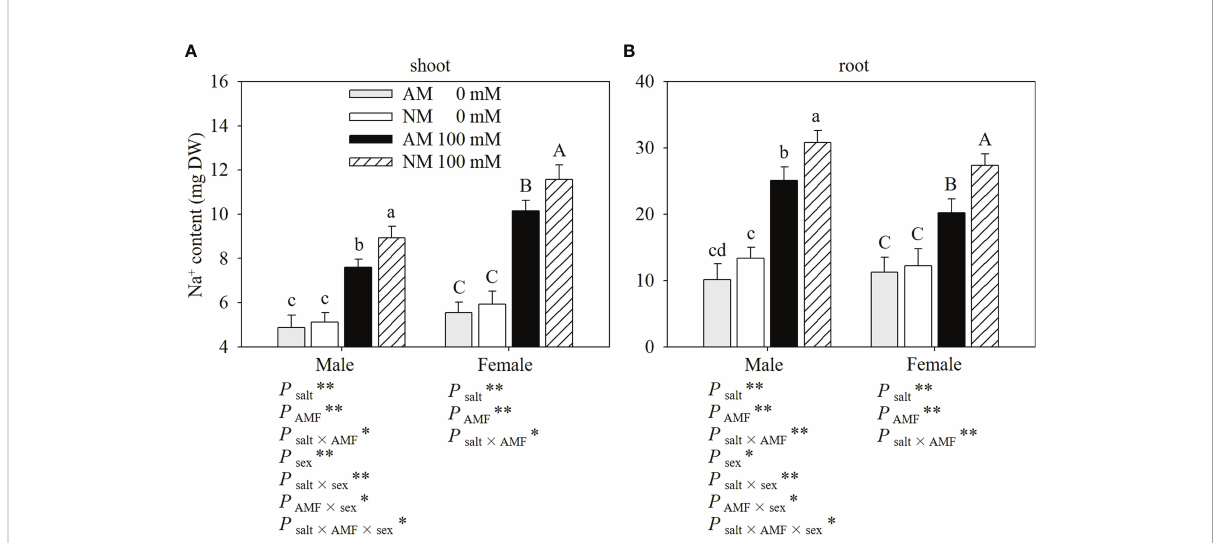
FIGURE 3 Effects of AMF inoculation on Na + contents of shoots (A) and roots (B) in males and females under different salt conditions AM, AMF inoculation; NM, non-inoculation; 0 mM, without salt stress; 100 mM, under salt stress; AMF, AMF formation; **: signi fi cant effect at P ≤ 0.01; *: signi fi cant effect at 0.01 < P ≤ 0.05; NS: no signi fi cant effect. Different letters (lowercases for males and capital letters for females) indicate signi fi cant difference at P ≤ 0.05, the data are means ± SD (n =